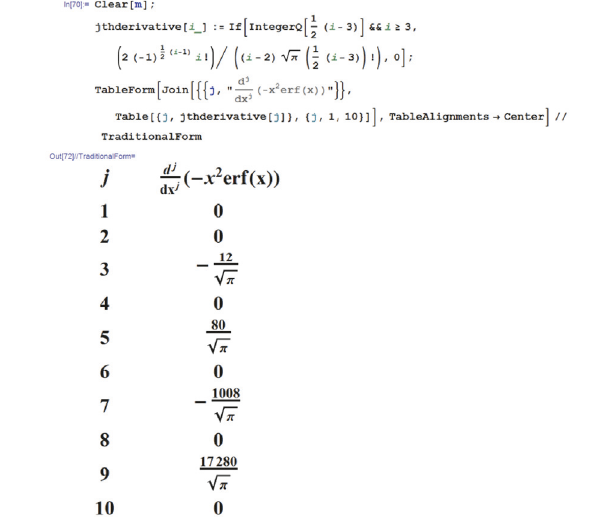
Figure 8: n-th derivative of new special function 𝑇(𝑥) .